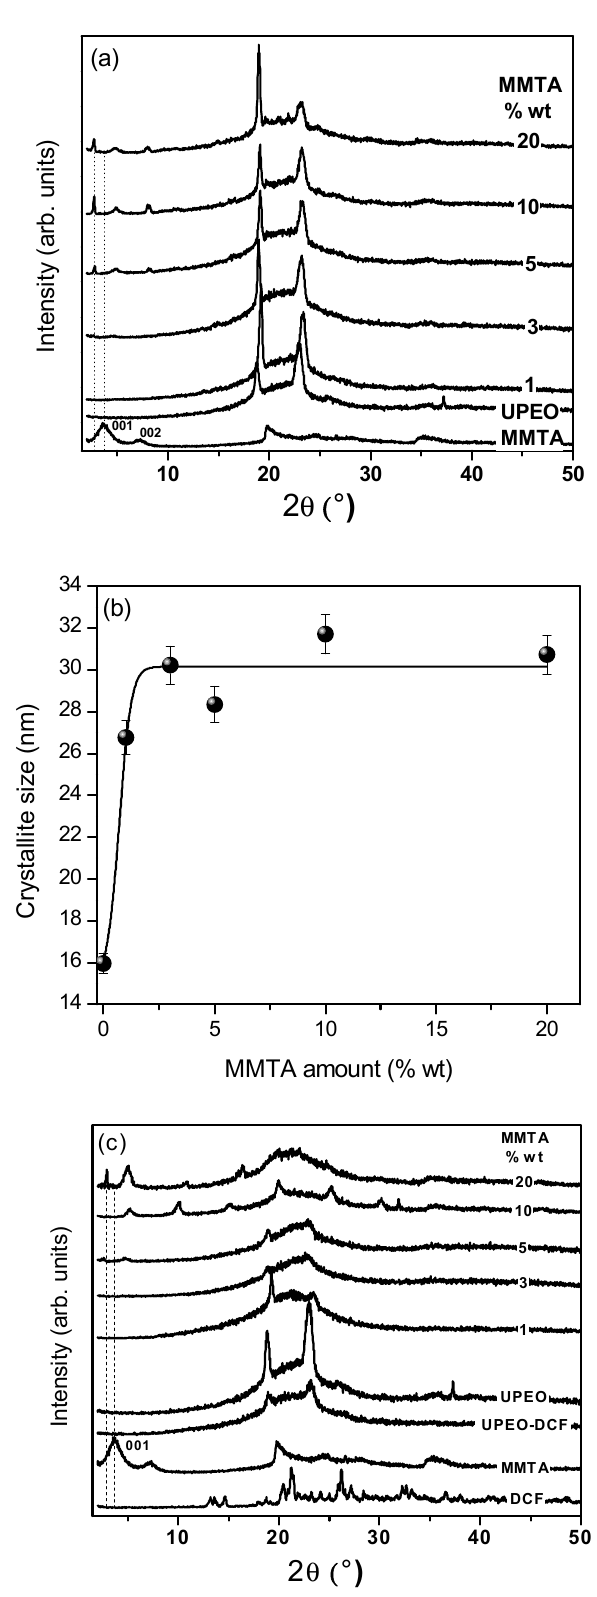
Figure 1. XRD patterns of ( a ) MMTA Cloisite ® 20A, UPEO, and UPEO–MMTA with different amounts of MMT, ( b ) crystallite size of UPEO as a function of MMTA content, and ( c ) DCF powder, MMTA Cloisite ® 20A, unloaded UPEO, and 5% DCF-loaded hybrid UPEO and UPEO–MMTA nanocomposites.